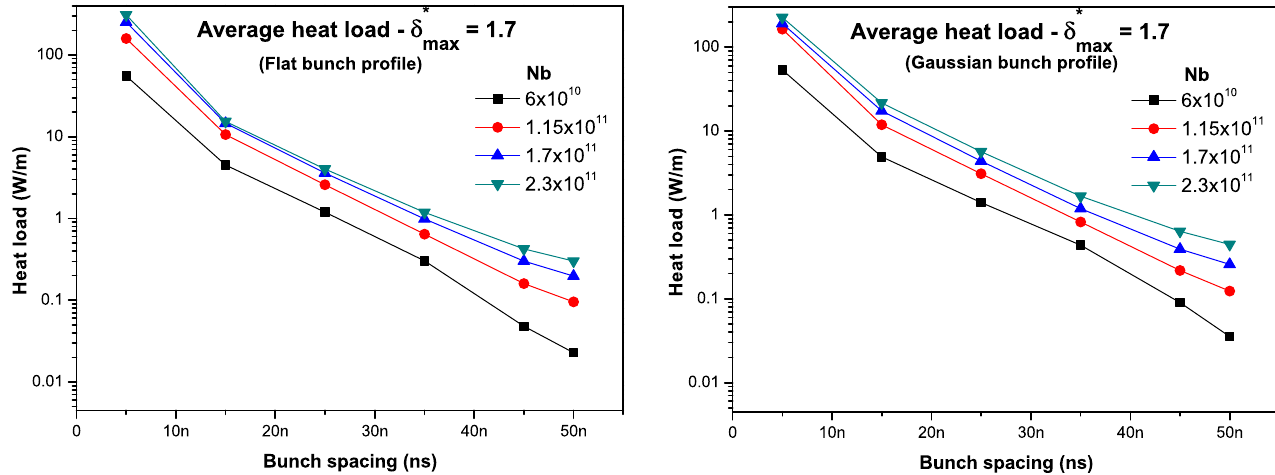
FIG. 15. Average heat load in function of the bunch spacing and a (cid:1) (cid:3) max ¼ 1 : 7 for (a) flat bunch profile and (b) nominal Gaussian profile.